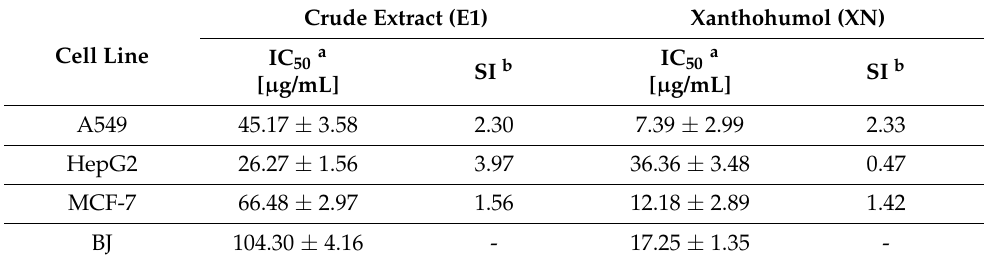
Table 7. The anti-proliferative activity and selectivity index of compounds from Marynka hop variety. Crude Extract Cell Line